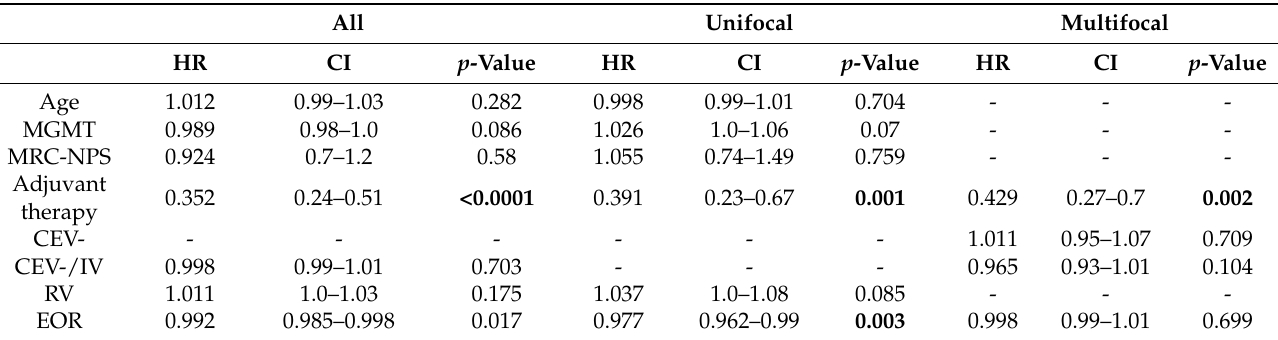
Table 2. Multivariate Cox